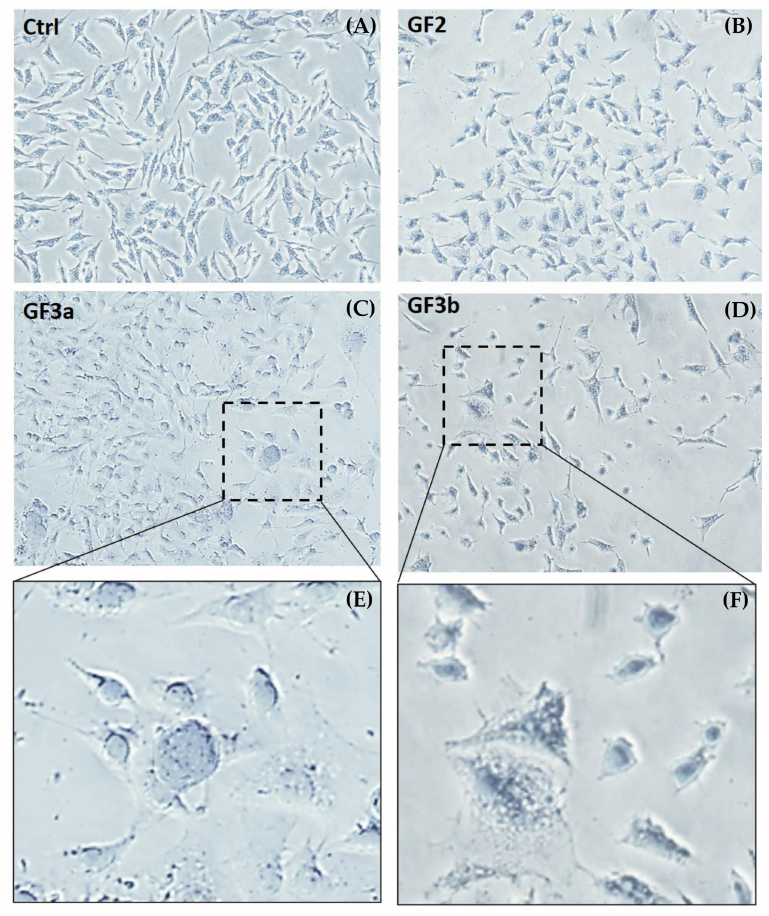
Figure 4. Representative images of HT22 cells treated with GF2, GF3a, and GF3b fibrous zeolites. The images were acquired by an optical microscope with a 10 × objective after the treatment with 1 µ m of GF2, GF3a, and GF3b zeolites. ( A ) control, ( B ) erionite GF2, ( C ) mesolite GF3a, and ( D ) thomsonite GF3b. The region bounded by the box is an enlarged region for the GF3a mesolite ( E ) and GF3b thomsonite ( F ) samples that highlight the morphologic changes of treated-HT22 cells. Scale bar 200 µ